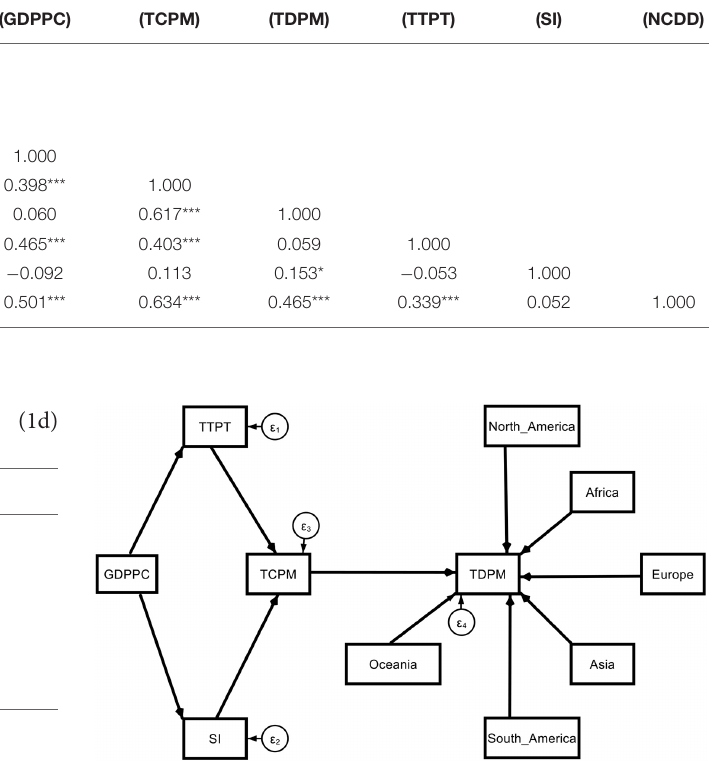
Model 2. Theoretical path models (determinants of COVID-19 deaths via old